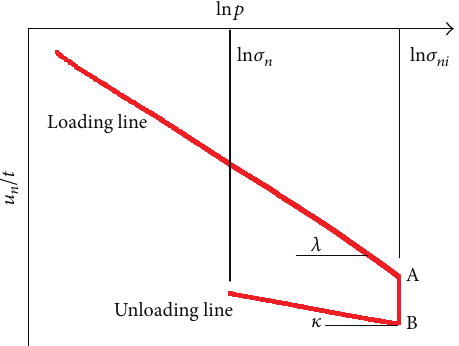
Figure 12: 𝑢 𝑛 -ln 𝑝 plots of the loading and unloading process in the